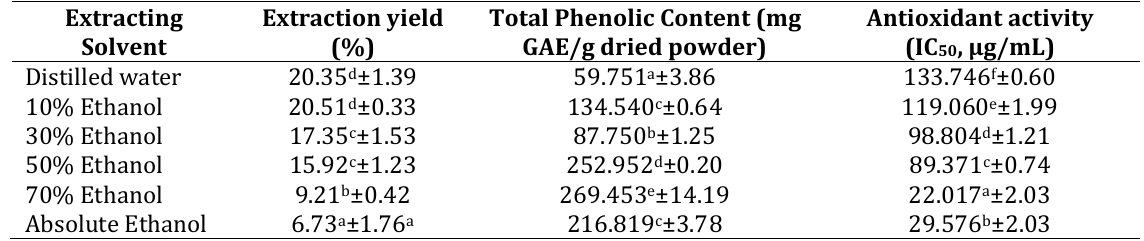
Table I. Extraction yields, total phenolic contents, and antioxidant activities of S. arvensis extracts Extracting